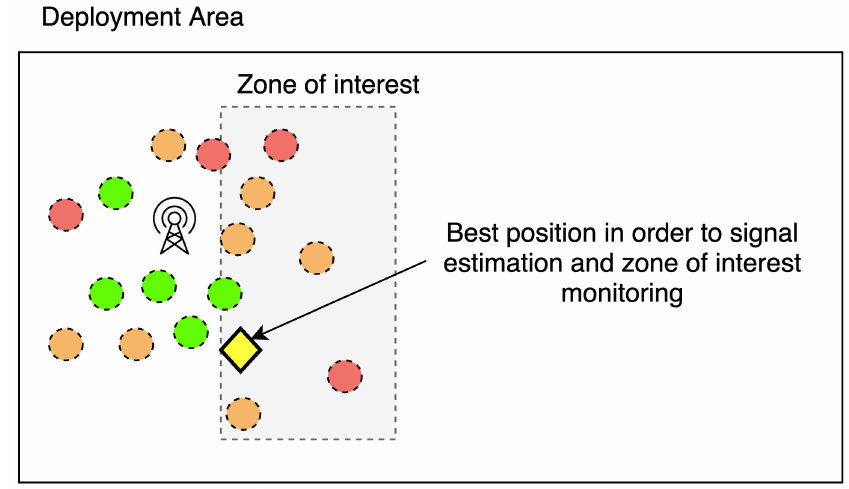
Figure 3. Example of optimal proposed position for a node.